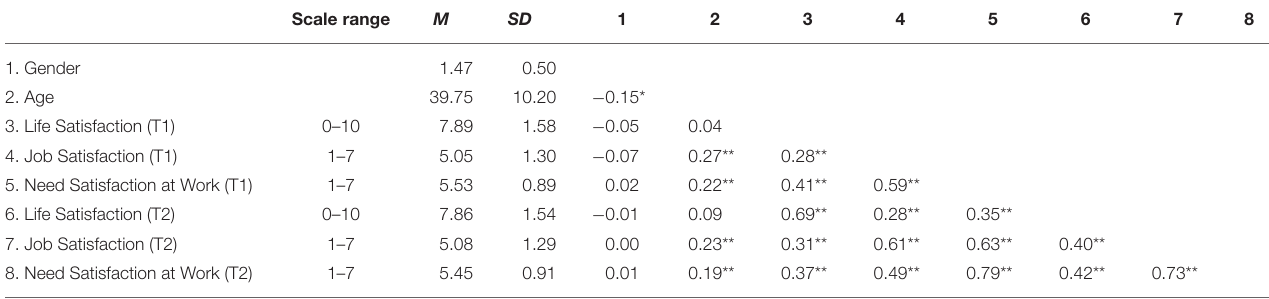
TABLE 4 | Descriptives and inter-correlations between all study 2 variables, at Time 1 (T1) and Time 2 (T2) (longitudinal data). Scale range